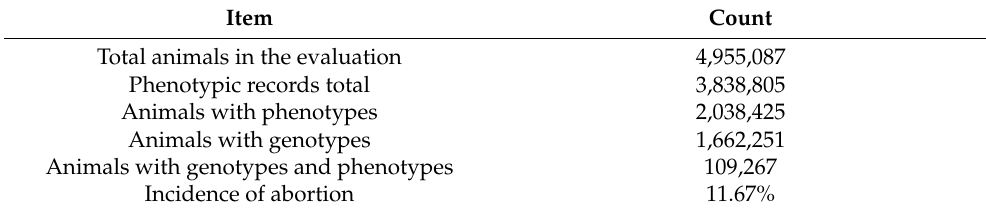
Table 1. Characteristics of the data in the genomic evaluation for abortion in Holsteins (April 2022).